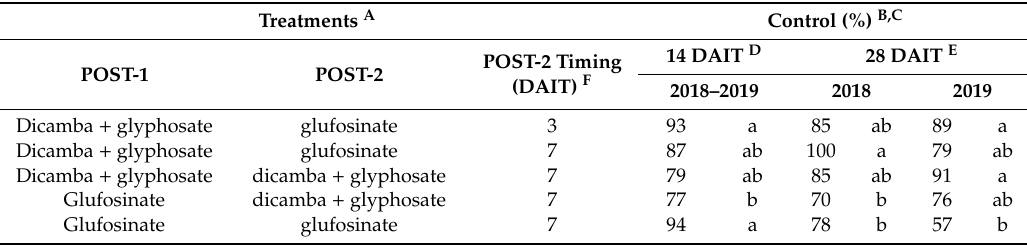
Table 4. Palmer amaranth control as a ff ected by sequential applications of dicamba and glufosinate in 2018 and 2019 field